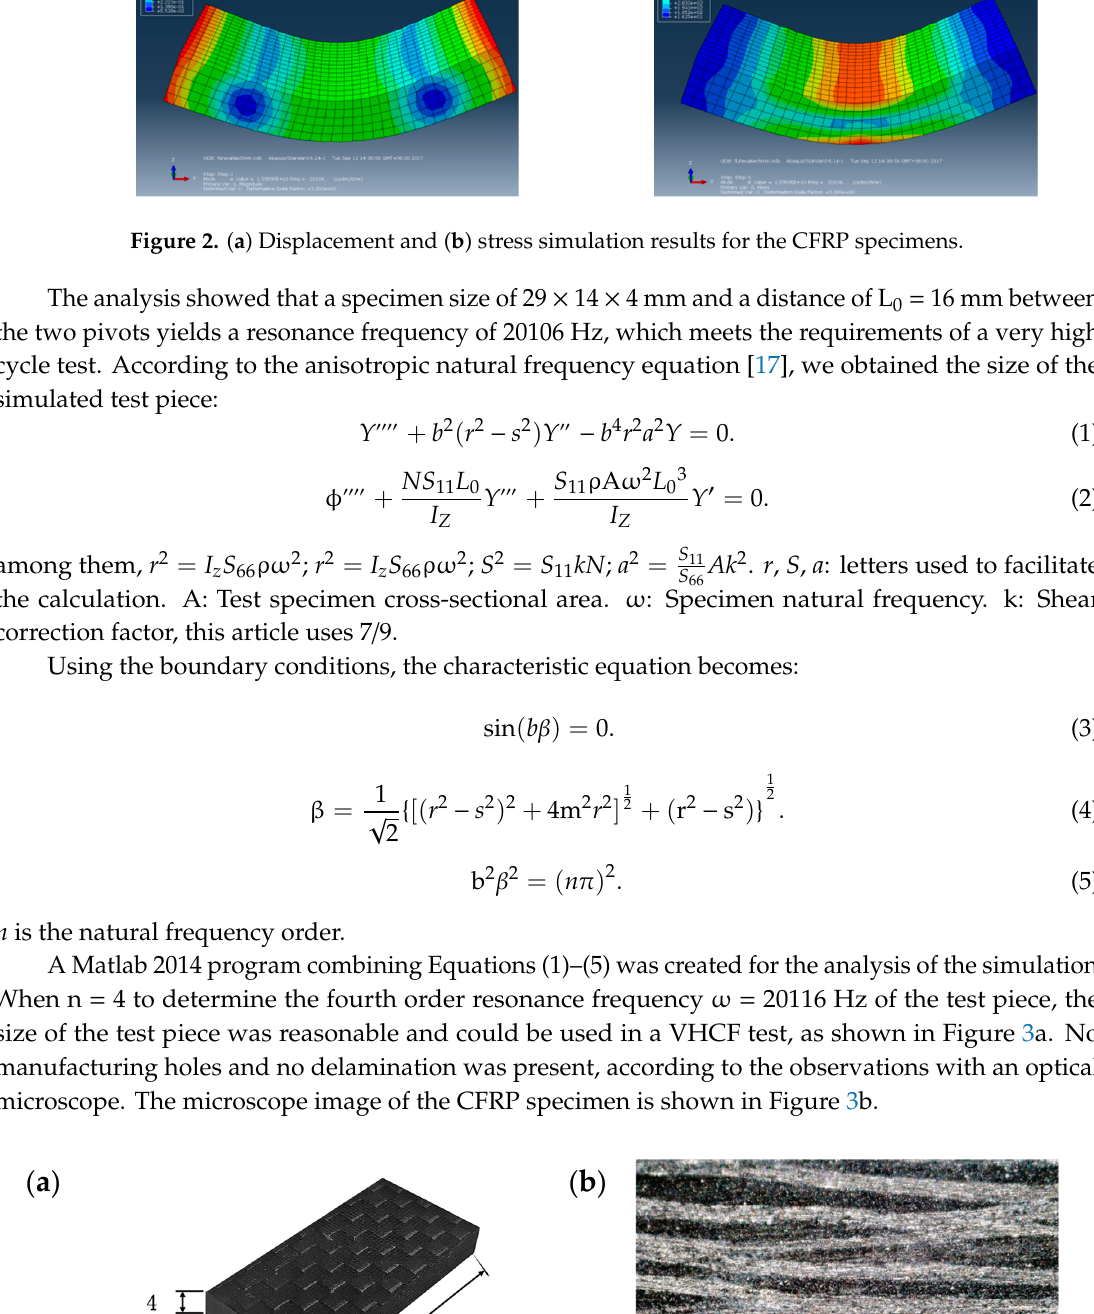
Figure 2. ( a ) Displacement and ( b ) stress simulation results for the CFRP specimens.